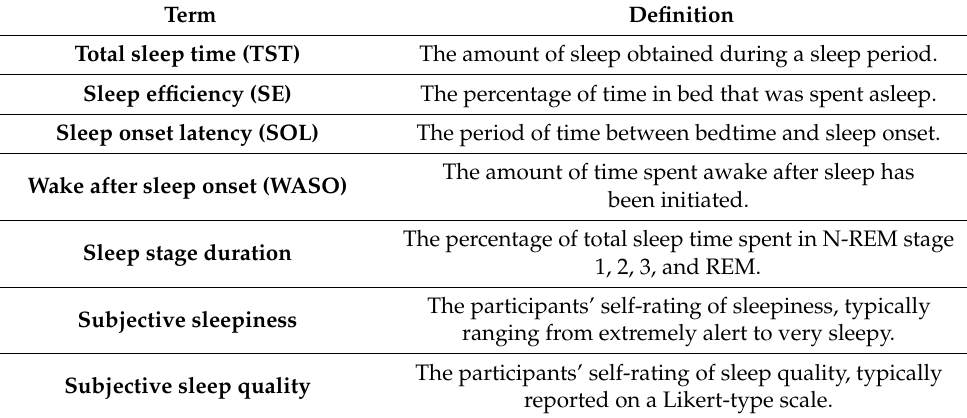
Table 1. Sleep related definitions